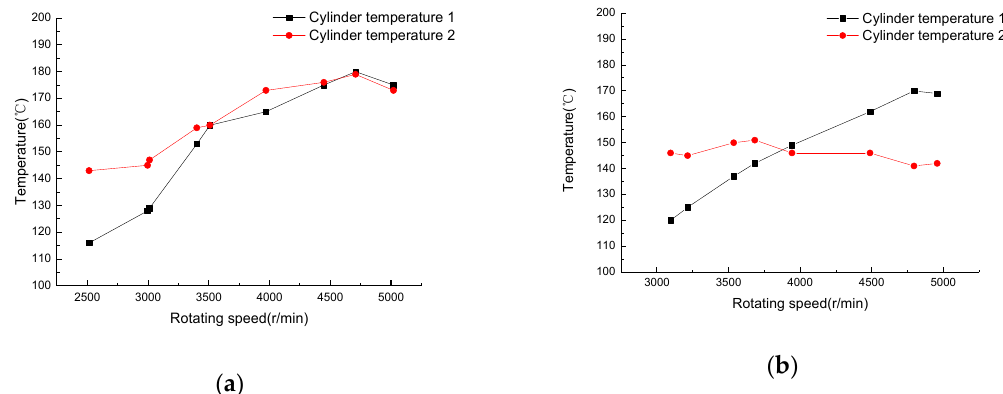
Figure 6. Temperature change chart of two cylinders under normal condition and low fuel pressure condition. ( a ) Change chart of cylinder temperature in normal condition, ( b ) Change chart of cylinder temperature when fuel pressure is low .